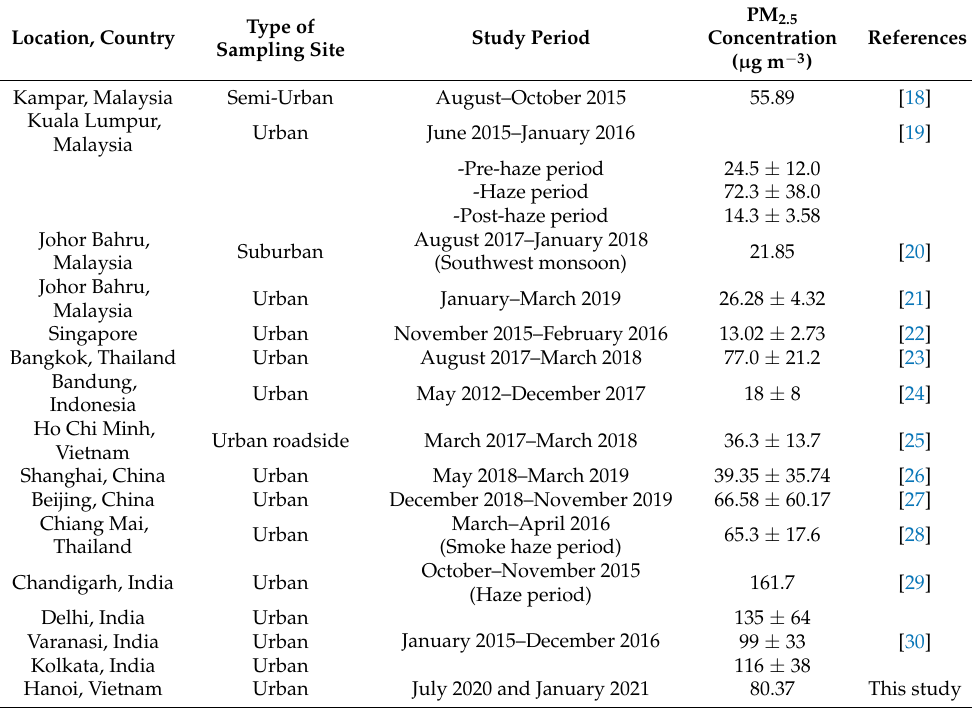
Table 2. Comparison of PM 2.5 concentrations in this study and other studies. Location,